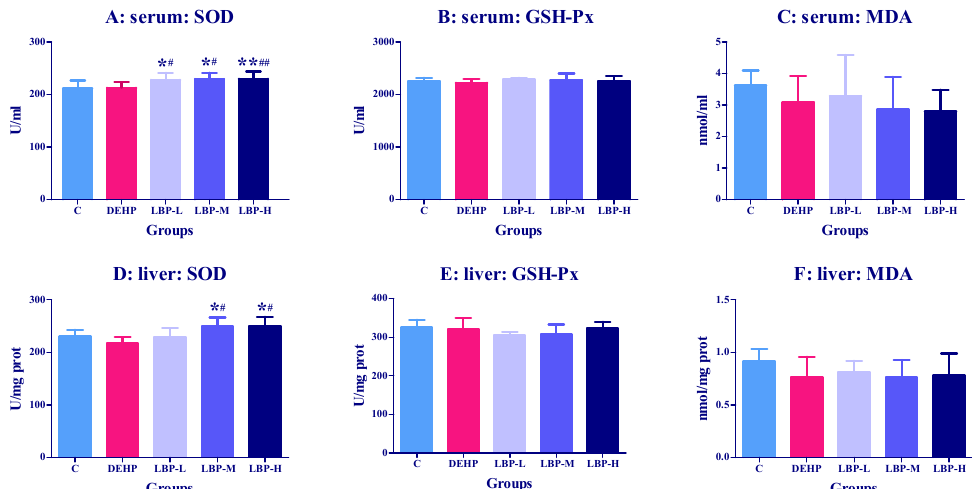
Figure 1. Effects of Lycium barbarum polysaccharide (LBP) intervention before Di(2-Ethylhexyl) phthalate (DEHP) exposure on serum and liver oxidative stress index in rats ( n = 8). Lycium barbarum polysaccharide was continuously given for seven days, and DEHP was fed on the last day. The related oxidative stress indexes (SOD, SGH-Px, MDA) in serum and liver were determined by ELISA kit. ( A , D ): activities of SOD in serum and liver, respectively. ( B , E ): activities of GSH-Px in serum and liver, respectively. ( C , F ): concentrations of MDA in serum and liver, respectively. Data are expressed by mean ± S.D. The significance of difference among treatment groups was determined by one-way ANOVA. * or **: compared with control group, p < 0.05 or 0.01; # or ## : compared with DEHP group, p < 0.05 or